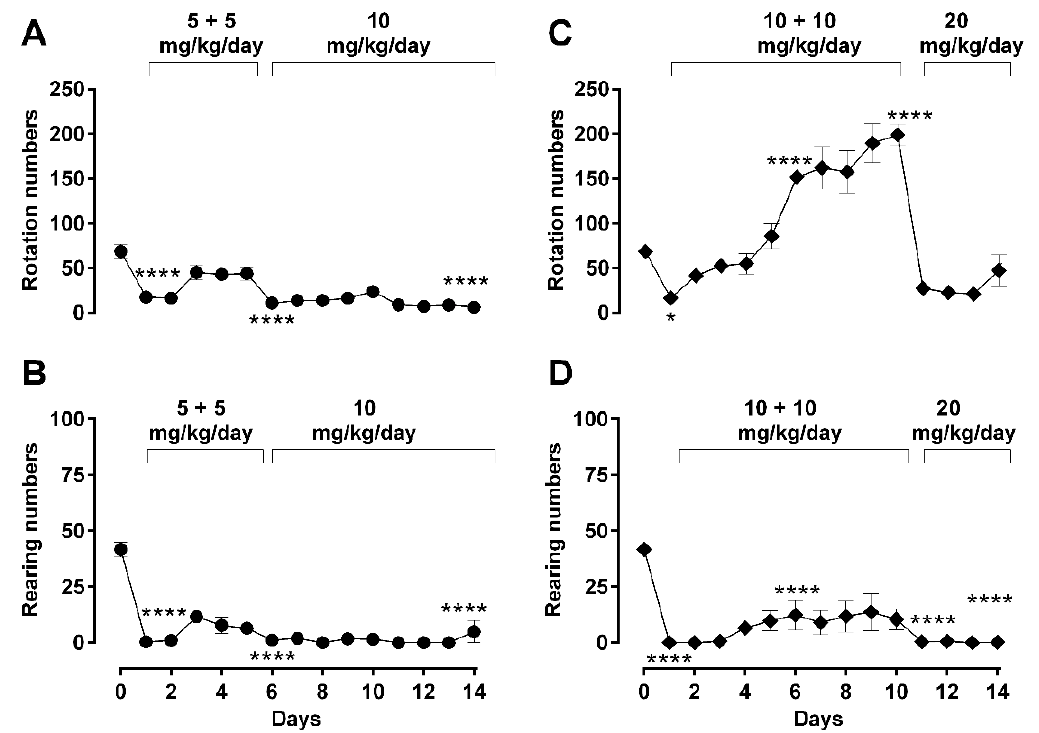
Figure 4. Effect of dosing regimen changes on advanced locomotor activity parameters (rearing and rotation) during long-term morphine administration. Rotation and rearing behaviors were recorded in an open-field arena after daily subcutaneous injections of morphine in male Sprague–Dawley rats, at a daily 30 min mark post-administration during a 5 min recording period. Activities of treated animals were measured as rotation numbers ( A , C ) and rearing numbers ( B , D ). Two morphine regimens were respectively used in two different groups of animals: 5 (b.i.d.) → 10 mg/kg (A, B) and 10 (b.i.d.) → 20 mg/kg ( C , D ) over a total period 14 days, as described in Methods . Values are presented as mean ± SEM ( n = 6 animals per group). Error bars are sometimes too small to be visible. Statistically significant ( p < 0.05) differences compared against day 0 are shown as * p < 0.05, and **** p < 0.0001 and were calculated using one-way ANOVA with Dunnett’s multiple comparisons test. The behavioral differences between these two dosing groups are shown as the differences in their area under the curves (AUC) in Table 2, which indicates that differences were observed in rotation but not in rearing behavior.